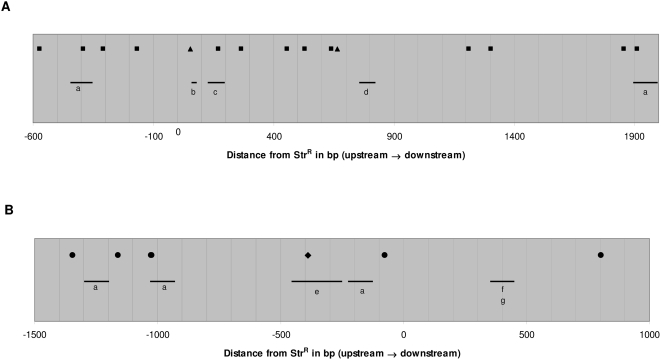
Alignment of methylation sites and regions containing multiple crossover endpoints in H. pylori DNA.Each panel is a representation of ∼2500 bp flanking a StrR site in strain J99 or 26695. Each horizontal bar represents a region that contains at least two recombination endpoints: a, two endpoints within 100 bp; b, two endpoints within 24 bp; c, three endpoints within 68 bp; d, two endpoints within 70 bp; e, two endpoints within 200 bp; f, two endpoints within 15 bp; g, four endpoints within 100 bp. (A) Map of sites in chromosomal DNA from strain J99 recognized by active 26695 restriction endonucleases for which the corresponding methylase is absent in J99. HpyAII recognition sites (GAAGA) are designated by filled squares (■). HpyAV recognition sites (CCTTC) are designated by filled triangles (▲). (B) Map of sites in 26695 chromosomal DNA recognized by active J99 restriction endonucleases for which the corresponding methylase is absent in 26695. Hpy99IV recognition sites (CCNNGG) are designated by filled circles (●). Hpy99I recognition sites (CGWCG) are designated by filled diamonds (◆).